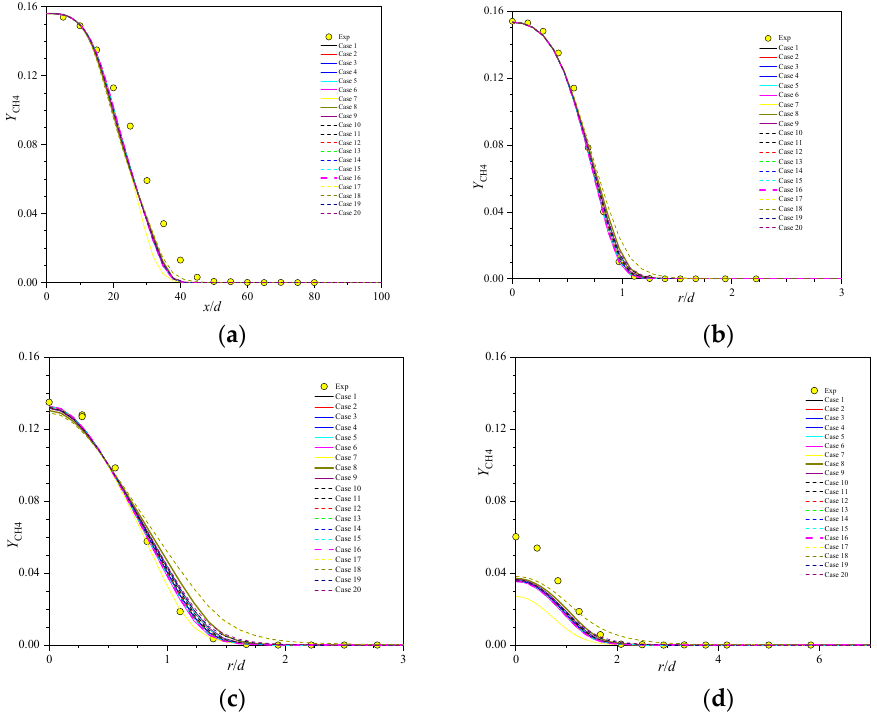
Figure 6. Comparison of measured [22,24] and predicted mean CH 4 mass fraction profiles for the Sandia Flame D with 20 combinations of the primary EDC primary constants 𝐶 (cid:2888)(cid:2869) and 𝐶 (cid:2888)(cid:2870) . ( a ) Sandia Flame D with 20 combinations of the primary EDC primary constants C D1 and C D2 . ( a ) @axis. @axis. ( b ) @ x / d = 7.5. ( c ) @ x / d = 15. ( d ) @ x / d = 30. ( b ) @ x / d = 7.5. ( c ) @ x / d = 15. ( d ) @ x / d =